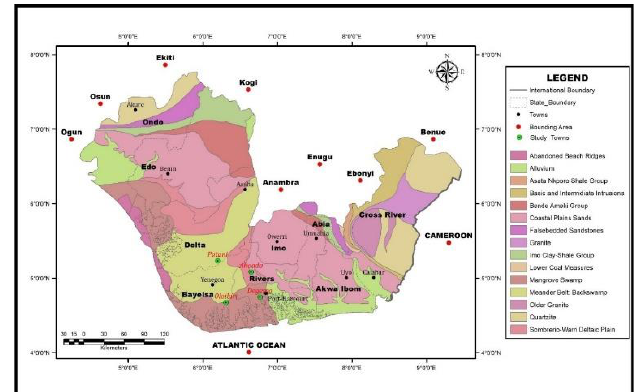
Figure 1: Map showing the location and geology of the study